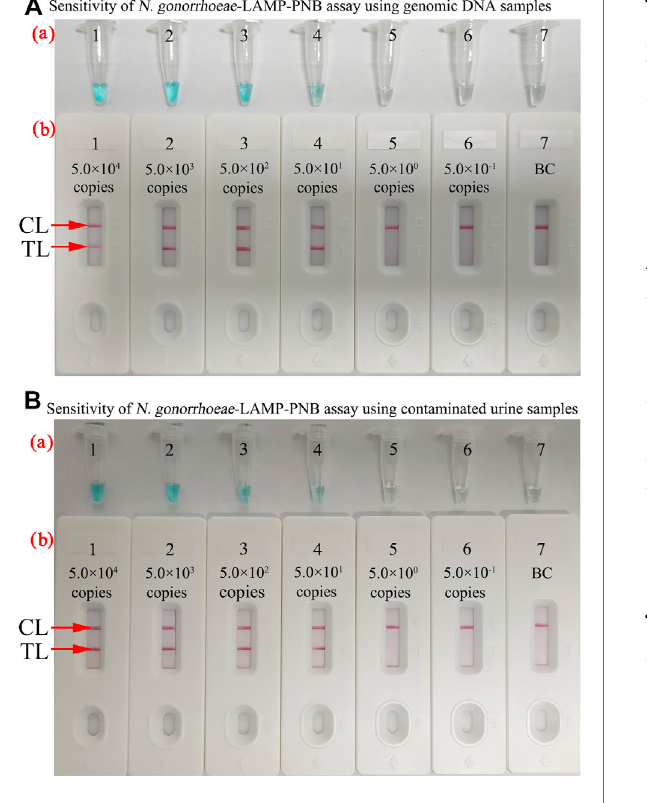
gonorrhoeae -LAMP-PNB technique, including genomic DNA template preparation ( ∼ 10 min), LAMP reaction (40 min), and resultant reporting ( ∼ 2 min), could be completed within 60 min.